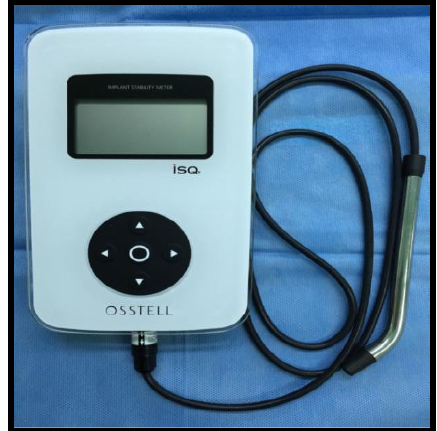
Figure 3: Osstell TM ISQ (Goteborg, Sweden, 4th